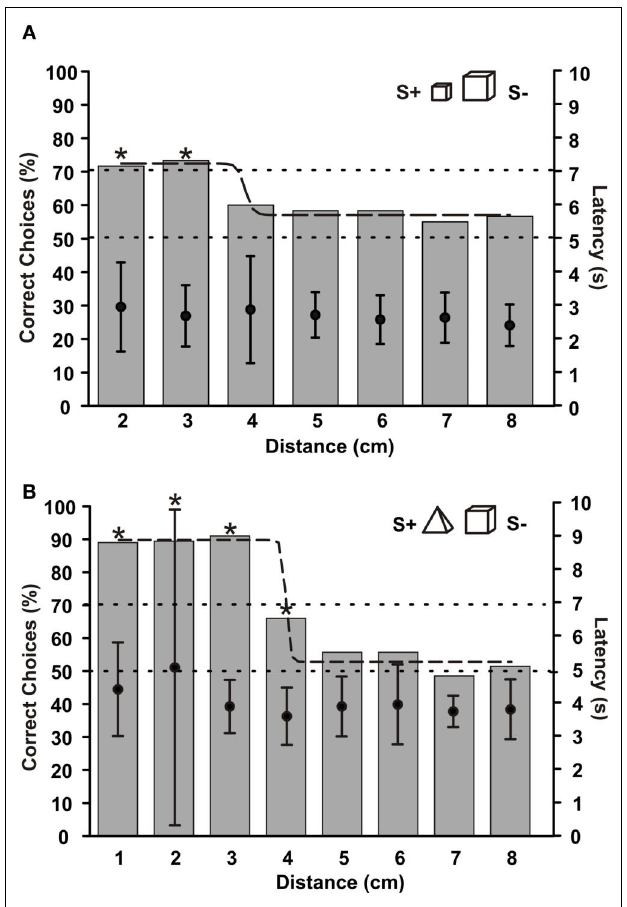
FIGURE 7 | (A) Mean choice frequencies of fi sh 2, which was trained to discriminate between a small (S + ) and a large cube. Objects were placed at different distances from their gates (abscissa). (B) Mean choice frequencies at different distances of objects for fi sh 3, which was trained to discriminate between a pyramid (S + ) and a cube (S − ). In both graphs, sigmoid curves were fi tted to the data. Dots within each column give mean choice latencies with standard deviation (right ordinate). N >